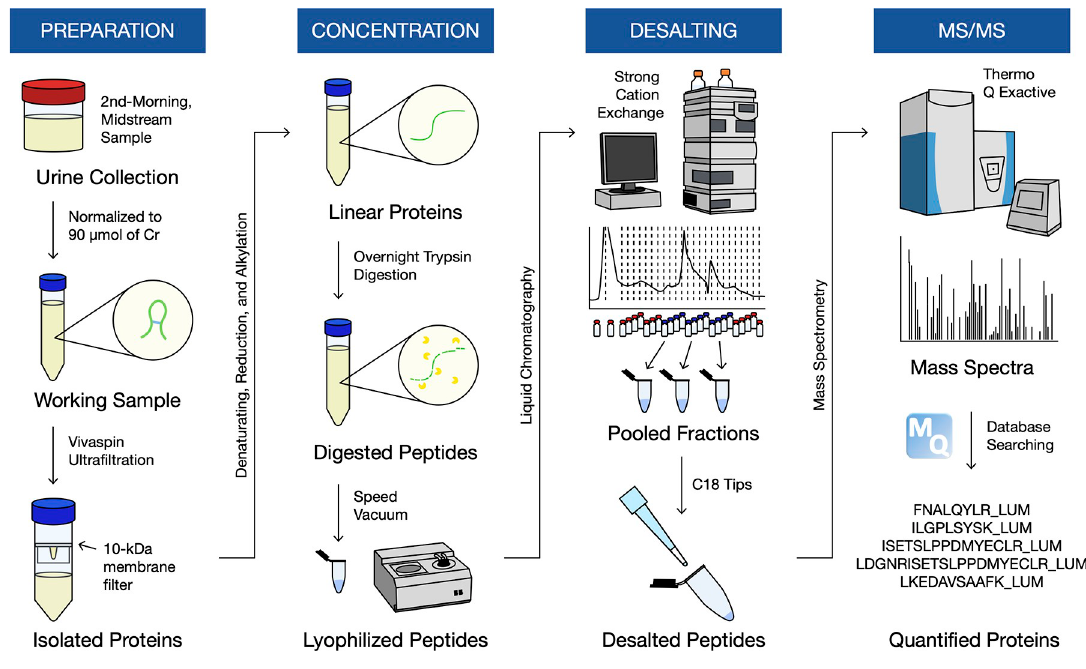
Fig 1. Workflow for the discovery-based urinary